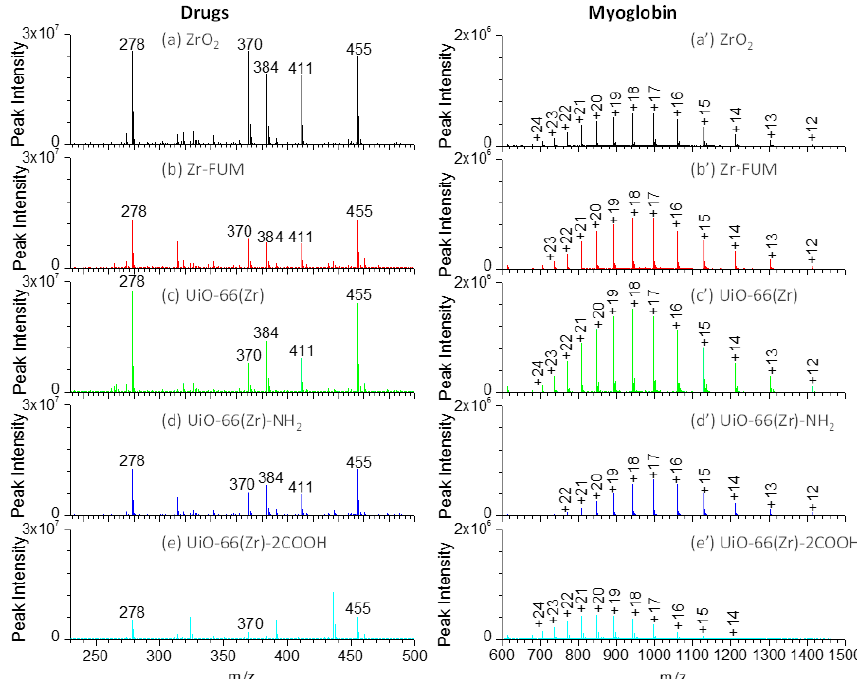
Figure 4. Mass spectra of a drug mixture containing amitriptyline ( m / z 278), amisulpride ( m / z 370), quetiapine ( m / z 384), risperidone ( m / z 411) and verapamil ( m / z 455) ( a–e ) and myoglobin ( a’–e’ ) using various Zr-based material-coated papers as substrates for paper spray: ( a ) and ( a’ ) ZrO 2 -coated paper, ( b ) and ( b’ ) Zr-FUM-coated paper, ( c ) and ( c’ ) UiO-66(Zr)-coated paper, ( d ) and ( d’ ) UiO-66(Zr)-NH 2 -coated paper, and ( e ) and ( e’ ) UiO-66(Zr)-2COOH-coated paper ( Note : For drug analysis: sample volume, 2 µ L of 1:1 methanol/water containing 10 µ g mL − 1 of corresponding drugs; solvent, 25 µ L acetonitrile; voltage: 3.5 kV. For myoglobin analysis: sample volume, 5 µ L; sample concentration, 50 µ g mL − 1 for myoglobin; solvent: 25 µ L 1:1 methanol/water; voltage: 3.5 kV).